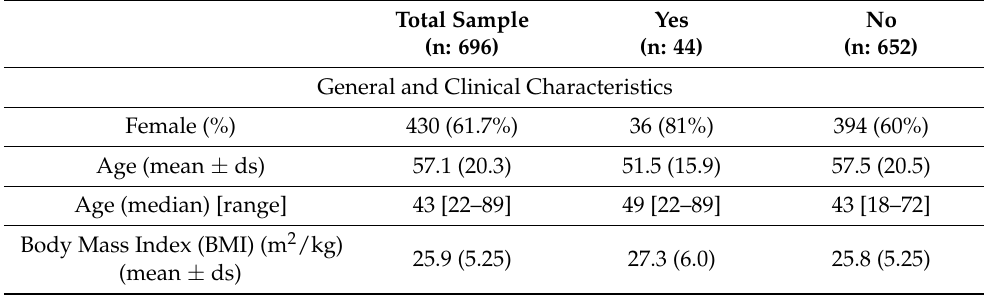
Table 1. Characteristics of study population according to the need to continue analgesic therapy in the post-acute COVID-19 (YES: those who continued taking analgesics in the post-acute phase; NO: those who did